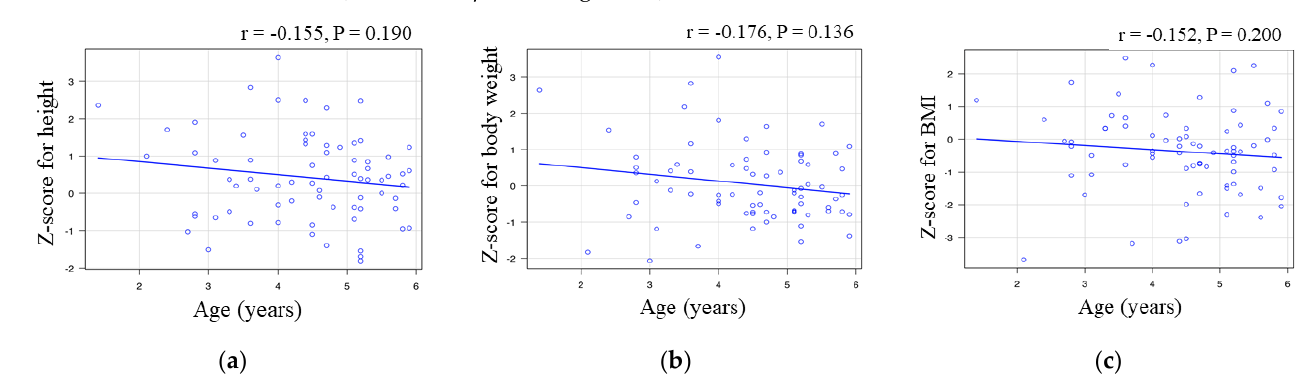
Figure 2 . Correlation between age and the Z-scores in the infant group: (a) age versus Z-score for height; (b) age versus Z-score for body weight; and (c) age versus Z-score for body mass index. The height; ( b ) age versus Z-score for body weight; and ( c ) age versus Z-score for body mass index. The correlation coefficient “r” is included. correlation coefficient “r” is